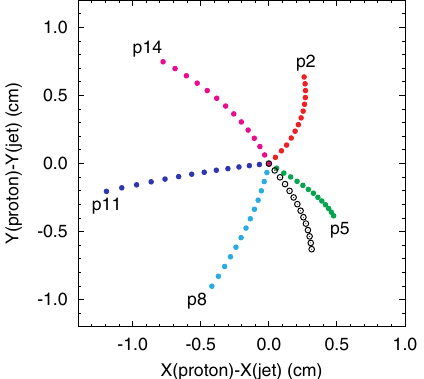
FIG. 9. The trajectory of the 8 GeV proton beam relative to the mercury jet in the x - y plane as the proton moves in z . Points on the outside start at z ¼(cid:2) 75cm at the labeled positions around the beam (see Fig. 8), and head toward a crossing with the jet at z ¼ (cid:2) 37 : 5cm (convergence of points in the diagram). Open circles are for the direction for which optimization studies were performed.